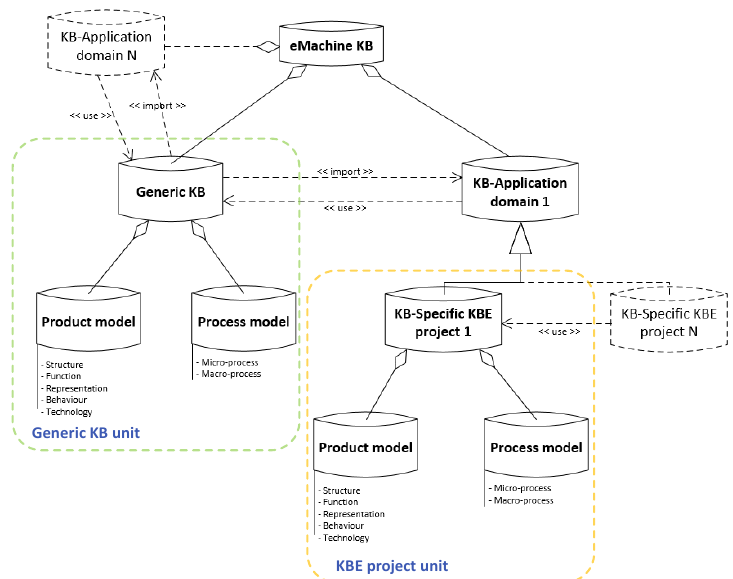
Figure 8. Knowledge base structure.